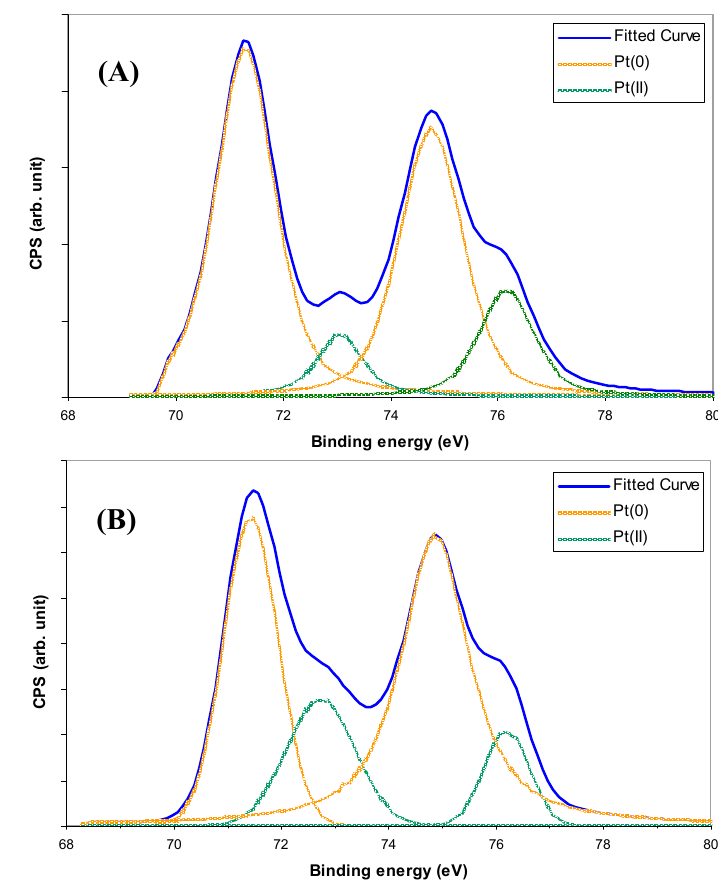
Figure 3. XPS spectra over the platinum Pt4f region for platinum photodeposited on WO 3 nanocubes (W7.6HS) using: ( A ) UV-A light for 1 h; ( B ) visible light for 3